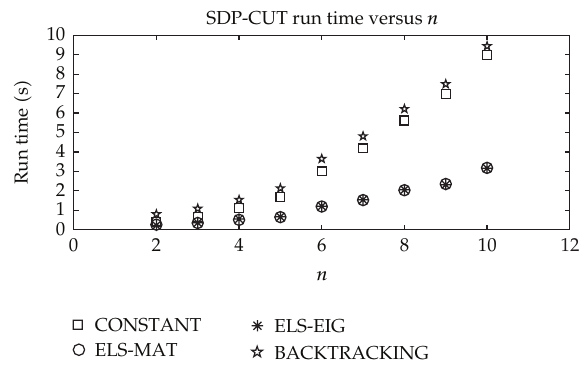
Figure 9: SDP-CUT time as it varies with the number of variables n